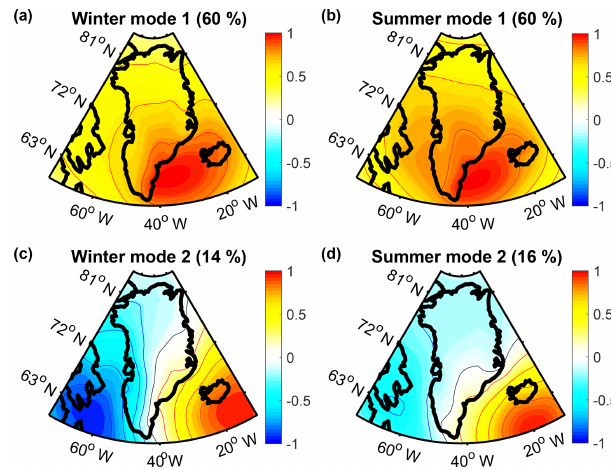
Figure 7. First and second EOF modes (normalized) of the sea level pressure variability over Greenland in winter and summer for the period 1988–2012, obtained from reanalysis data. The titles indi- cate the explained variance of the total temporal sea level pressure